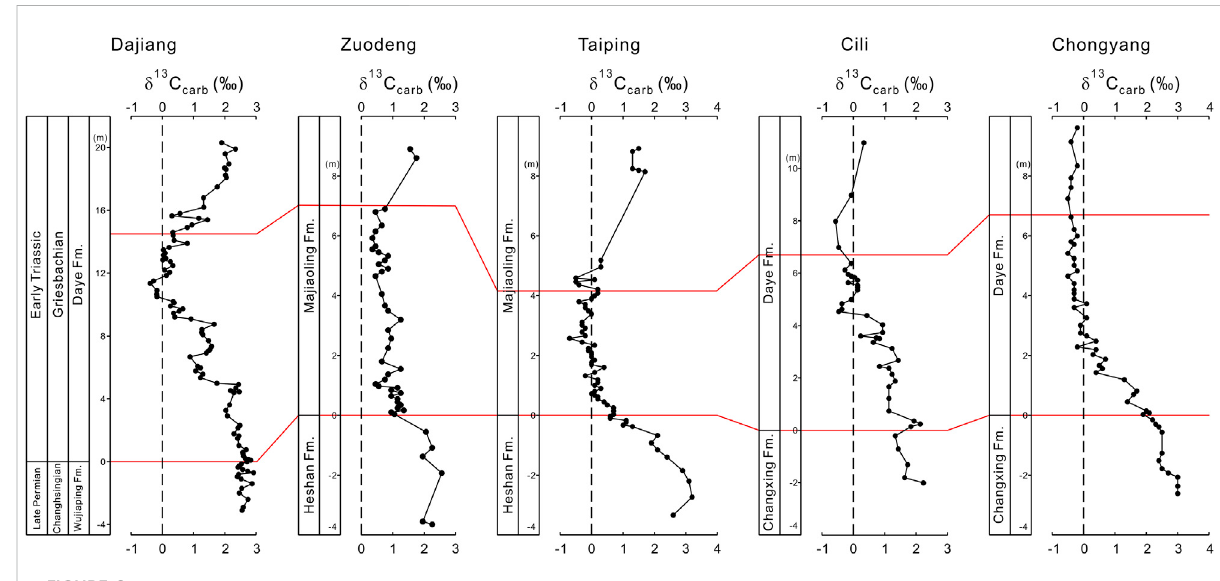
Comparison of δ 13 C carb records during the Permian-Triassic transition in South China. The data are from the Dajiang (this study), Zuodeng (Luo et al., 2011), Taiping (Luo et al., 2011), Cili (Luo et al., 2011), and Chongyang (Luo et al., 2011) section. The red lines indicate the onset and termination of the microbialite